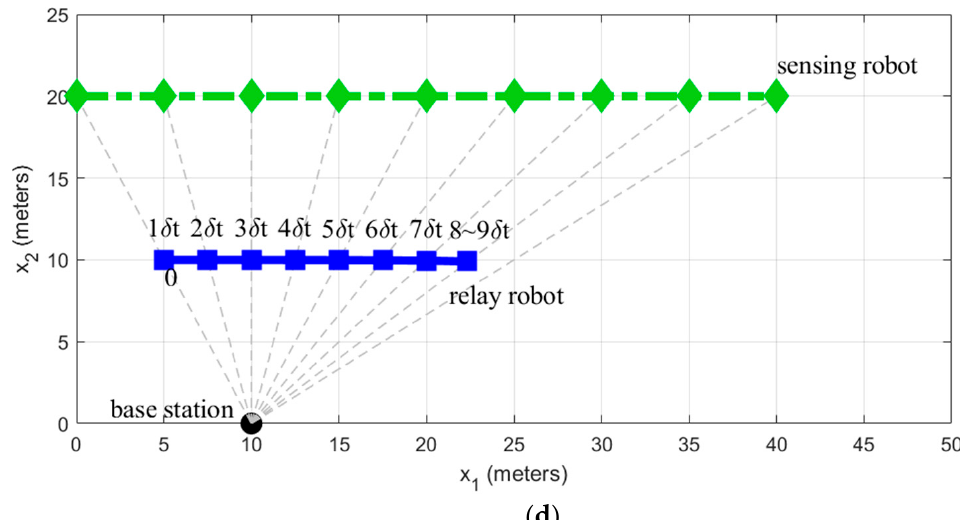
Figure 3. Optimal trajectories of the relay robot with non-JCMP, and those of the JCMP with data sampling rates η s = 1.0, 5.0, 10.0 Mbit/s: ( a ) non-JCMP, ( b ) JCMP, η s = 1.0 Mbit/s, ( c ) JCMP, η s = 5.0 Mbit/s, ( d ) JCMP, η s = 10.0 Mbit/s.